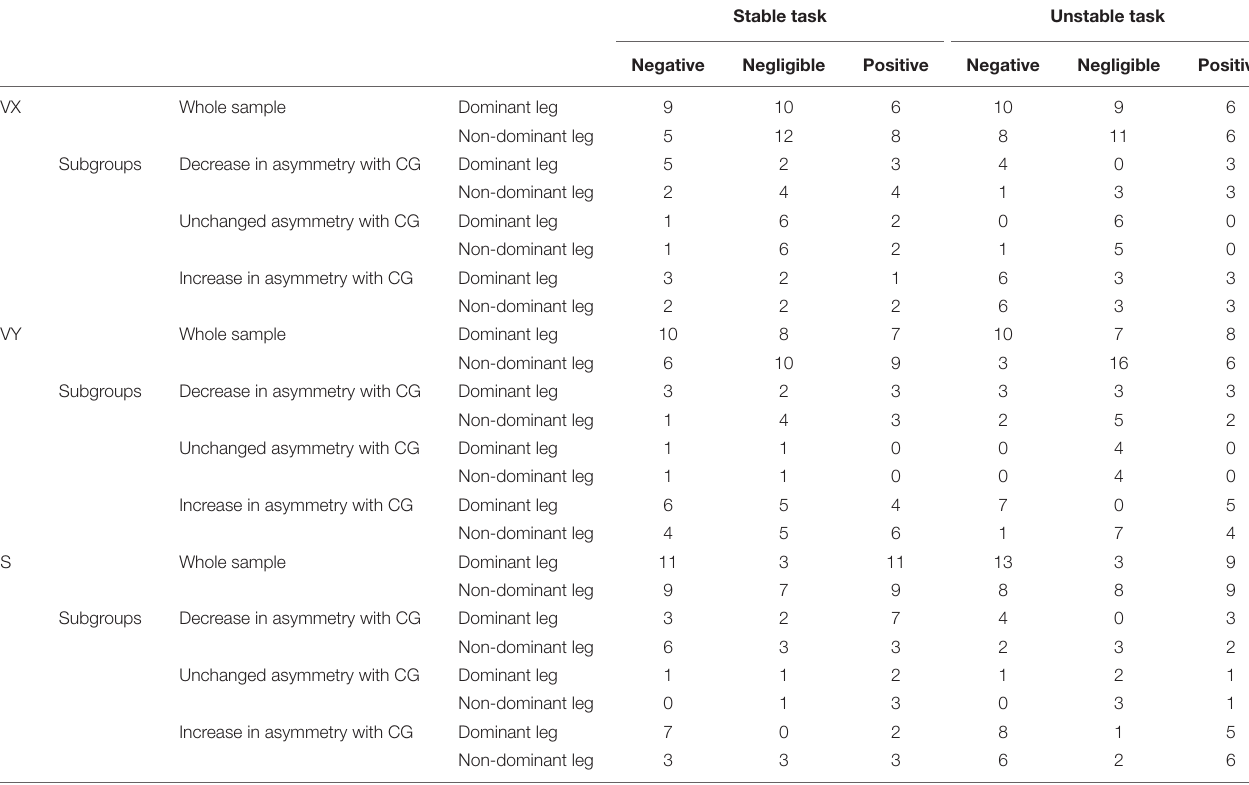
Subgroups of individuals were formed by distinguishing subjects in whom CG wearing had no substantial influence on asymmetry indexes (“unchanged asymmetry with CG” subgroup), subjects in whom CG wearing markedly increased the level of asymmetry (“increase in asymmetry with CG” subgroup) and subjects in whom CG wearing markedly decreased the level of asymmetry (“decrease in asymmetry with CG” subgroup). VX, mean velocity of the center of pressure along the medio-lateral axis; VY, mean velocity of the center of pressure along the antero-posterior axis; S, center of pressure surface area (90% confidence